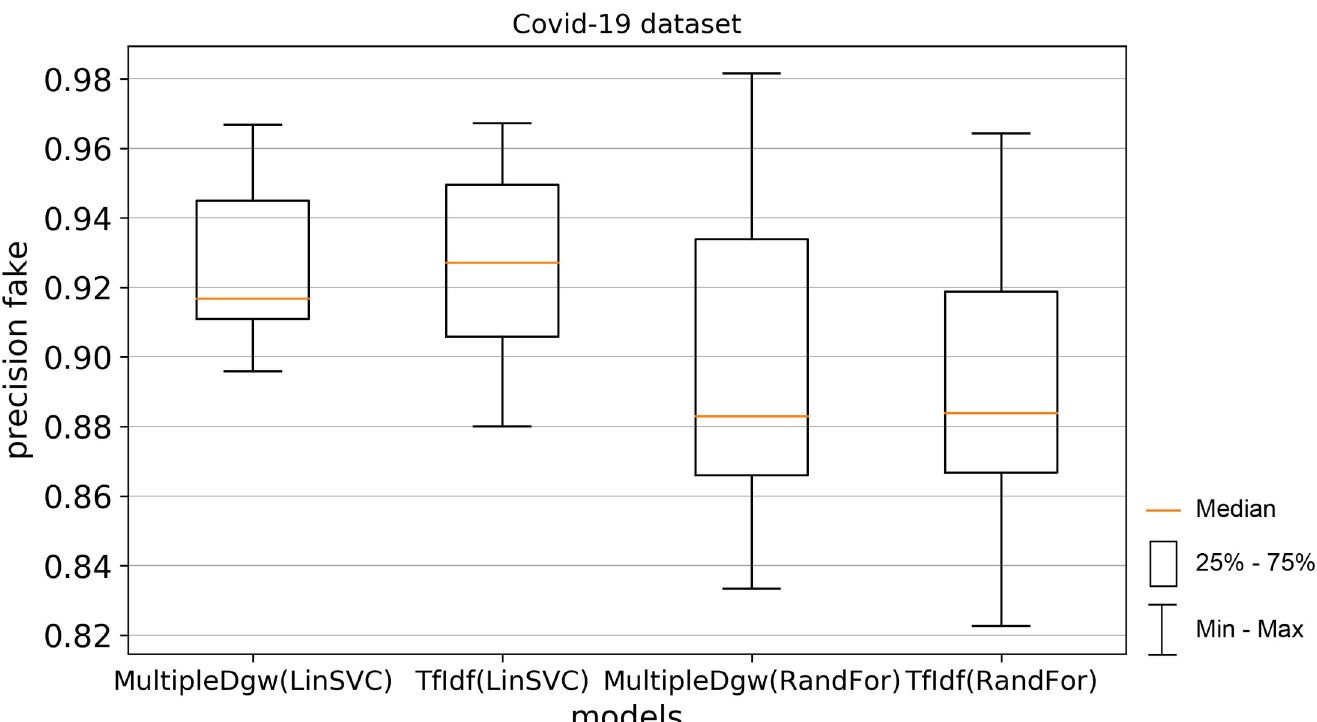
Fig 6. Boxplot for the model performance measurement—precision_fake for dataset Covid-19.